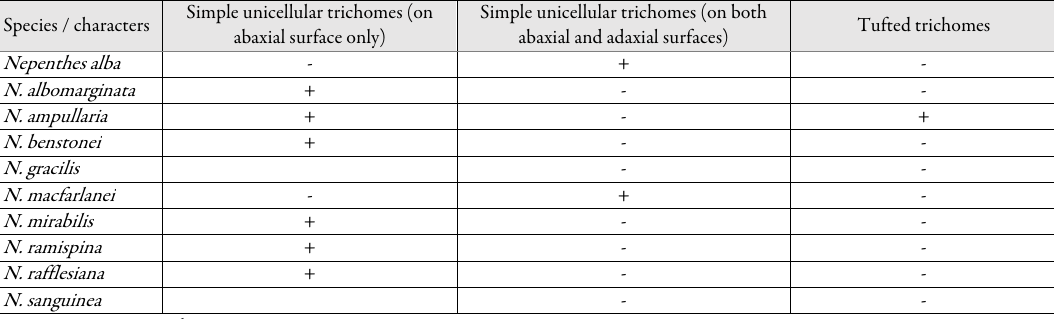
Table 5. Variation of appendages morphology observed in studied Nepenthes specimens Species /